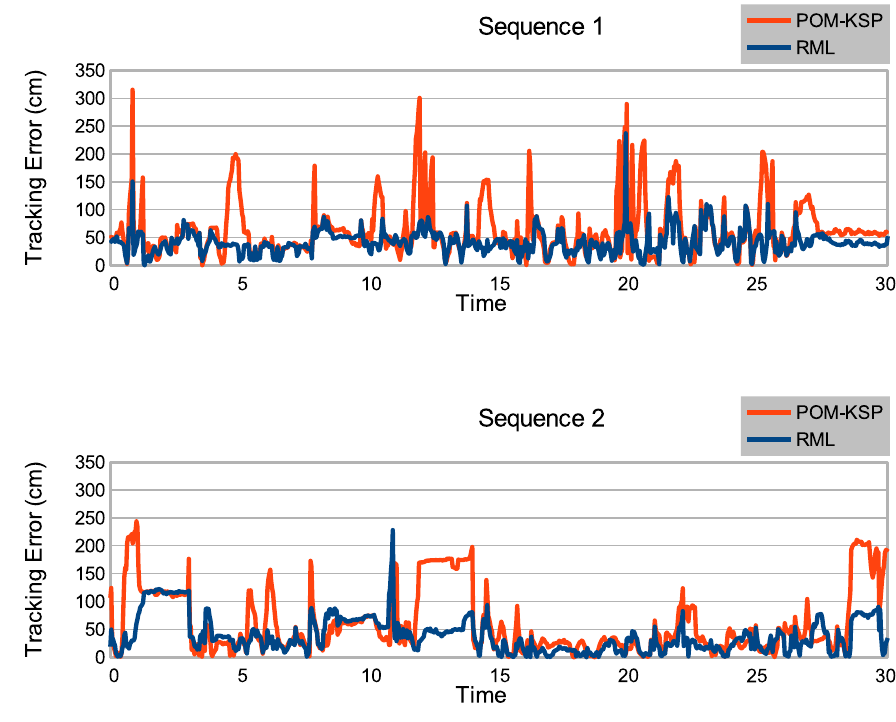
Figure 8. Tracking error (TE) for all compared frames.